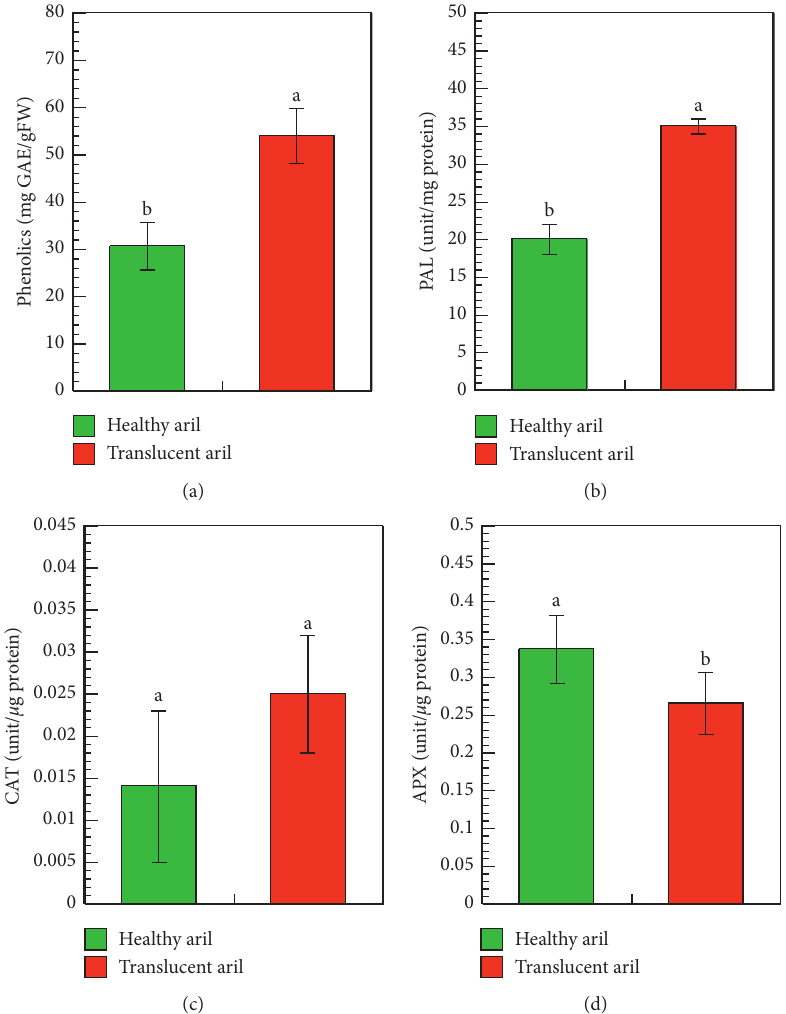
Figure 3: Phenolic content (a), phenylalanine ammonia lyase activity (b), catalase (c), and ascorbate peroxidase (d) in healthy and translucent arils. Means ( n � 4) with different lower-case letters on the bars are significantly